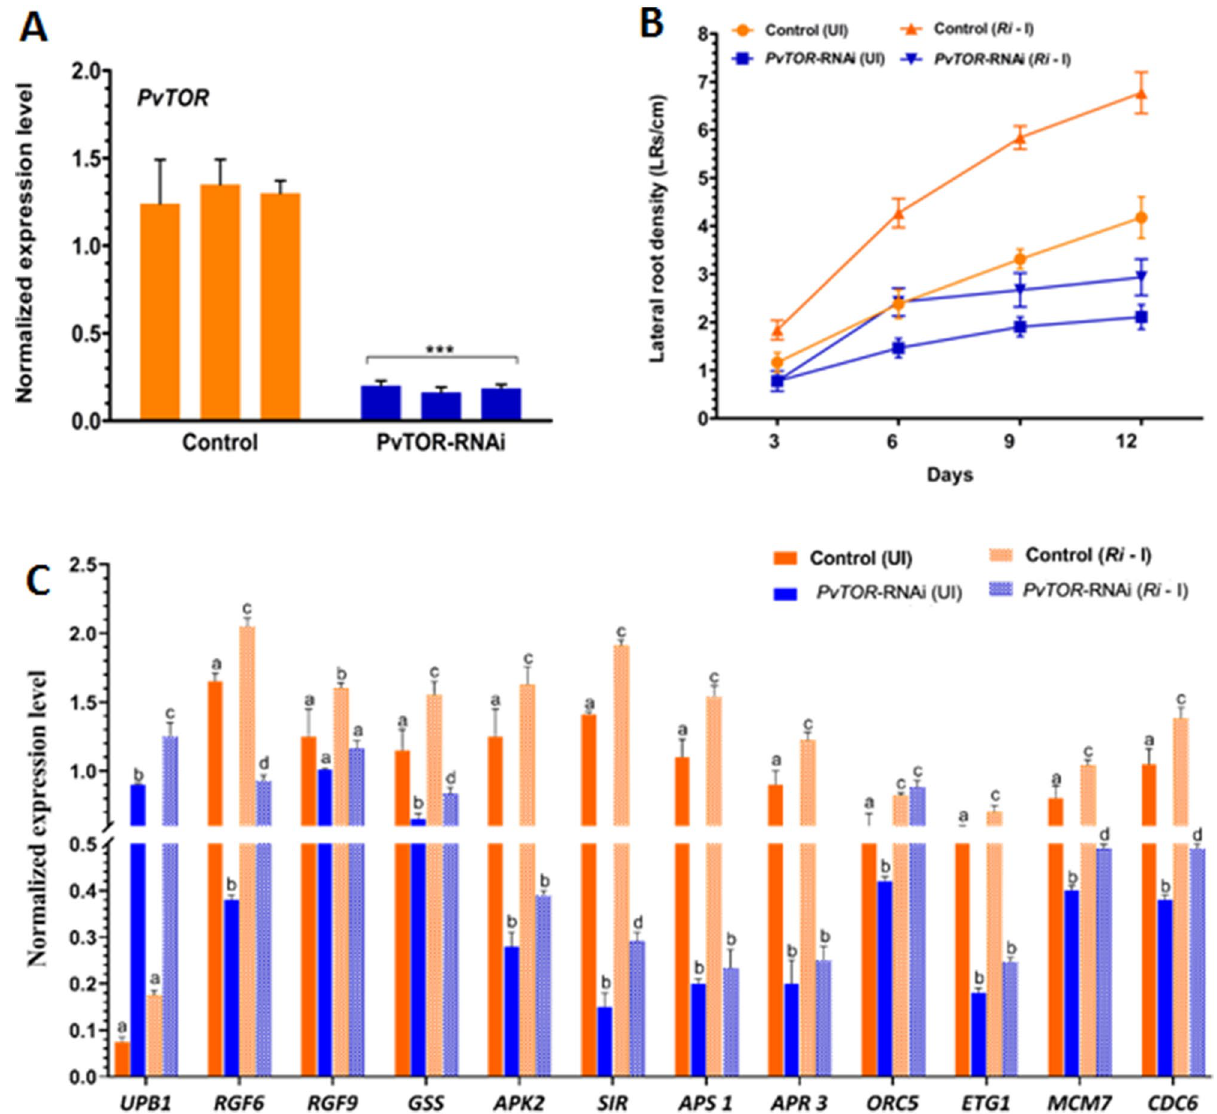
Figure 3. Knockdown of PvTOR inhibits AM fungus-stimulated lateral root production and downregulates the expression of root meristem regulatory genes in P. vulgaris. ( A ) Quantitative RT-PCR analysis of PvTOR transcript levels in control (empty vector) and PvTOR -RNAi roots at 10 days post emergence. Each bar represents three individual transformants (representative RNAi plant 1, 2, and 3). ( B ) Lateral root density